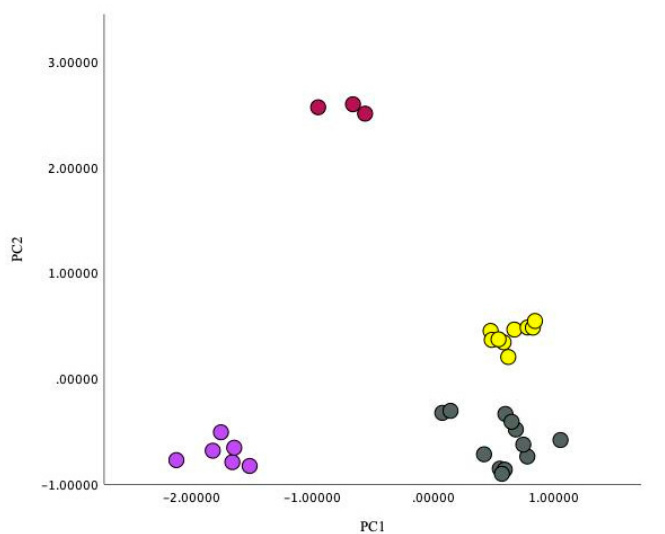
Figure 8. Bivariate plot showing obsidian artefacts and Bingöl A geological samples on PC1 and PC2 for the four compositional groups (yellow circles coding Bingöl A).